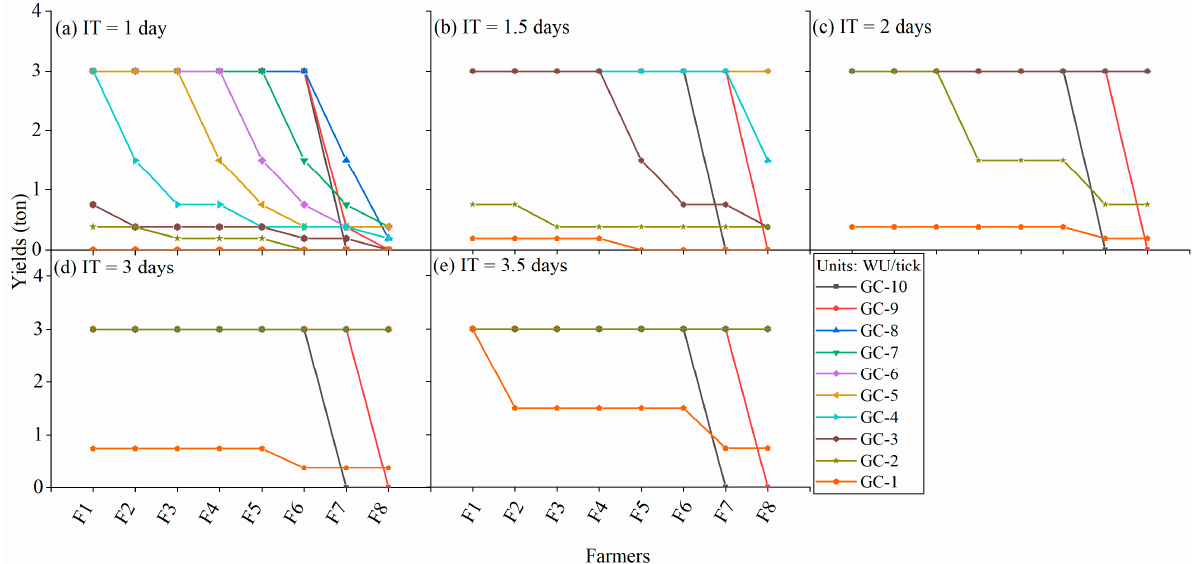
Figure 8. Yields per farmer with CD = 60 WU/tick under different irrigation time controls: (a) Farmers’ yields when IT = 1 day; (b) Farmers’ yields when IT = 1.5 days; (c) Farmers’ yields when IT = 2 days; (d) Farmers’ yields when IT = 3 days; (e) Farmers’ yields when IT = 3.5 days.